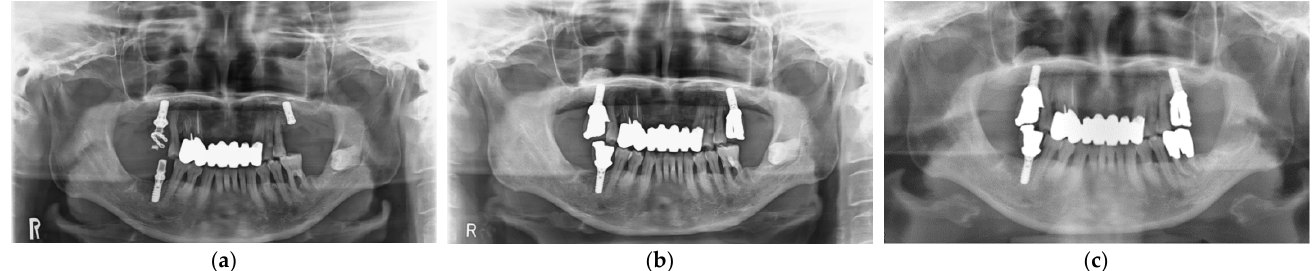
Figure 5. Panoramic radiographic images. SFE and implant at maxillary left molar site. ( a ) At implant placement; ( b ) At the delivery of final restoration; ( c ) At 3-year follow-up.